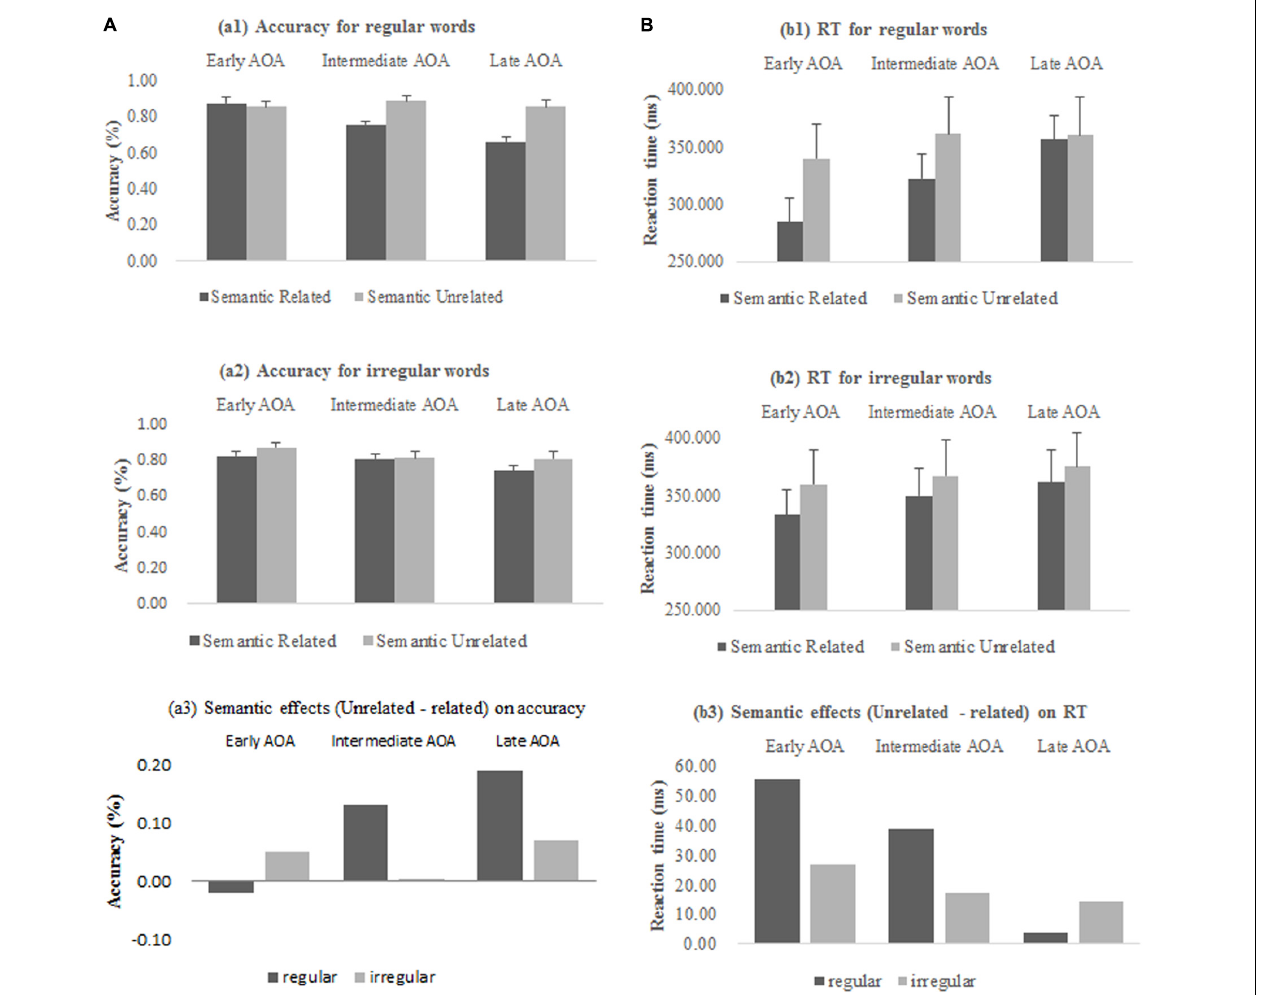
FIGURE 2 | Semantic effects on (A) accuracy rates and (B) reaction times across different